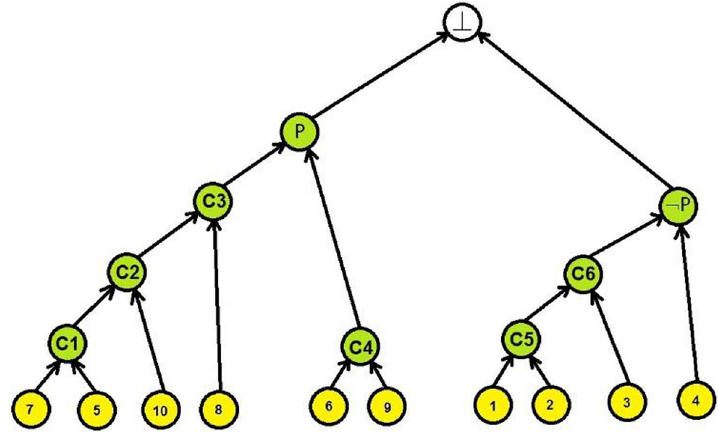
Fig. 5 The proof construct lattice for false value from the scenario